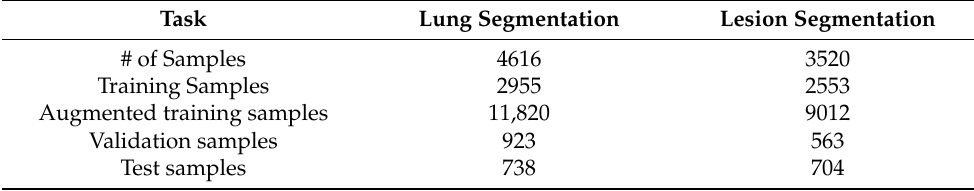
Table 4. Number of CT images per class and per fold before and after data